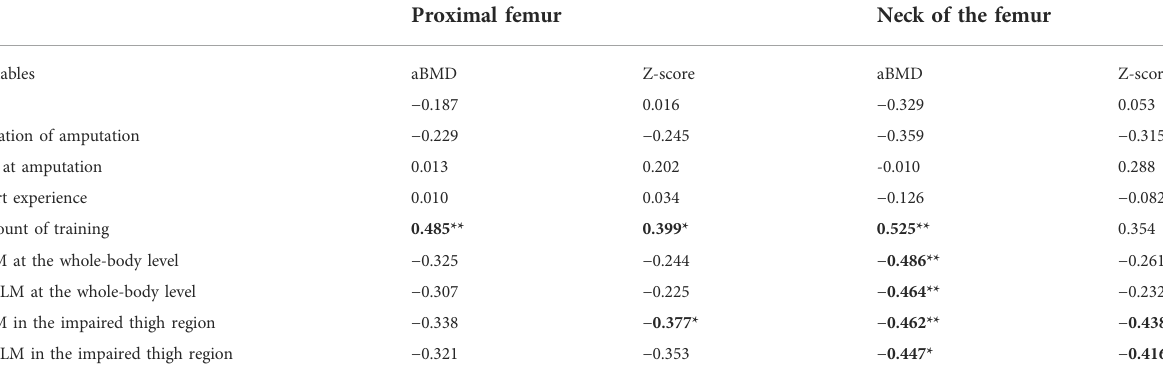
TABLE 3 Partial correlation coef fi cients(r PC )between general characteristics and body composition,and the DXA-measuredvariables at the hipscan of the impaired leg, accounting for the level of amputation (above-knee or below-knee amputation). Proximal femur Neck of the femur